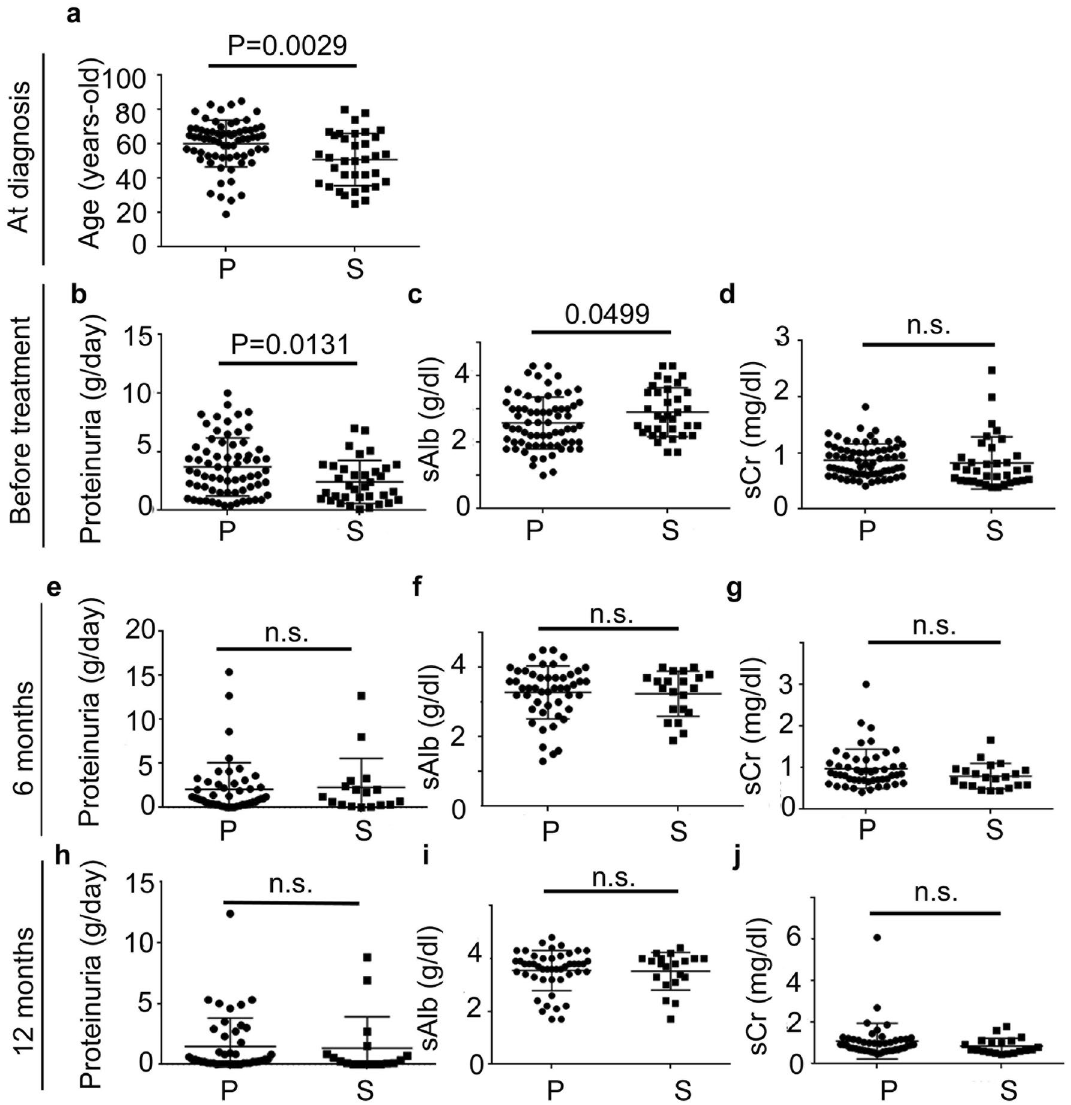
Figure 1. Changes in the clinical parameters of patients with primary and secondary MN during the 1-year follow up. ( a ) Age at diagnosis. The levels of proteinuria ( b , e , h ), serum albumin ( c , f , i ), and serum creatinine ( d , g , j ) just before the treatment ( b , c , d ), at 6 months ( e , f , g ), and at 12 months ( h , i , j ) after starting treatment. P primary membranous nephropathy, S secondary membranous nephropathy, sAlb serum albumin, sCr serum creatinine, n.s . not